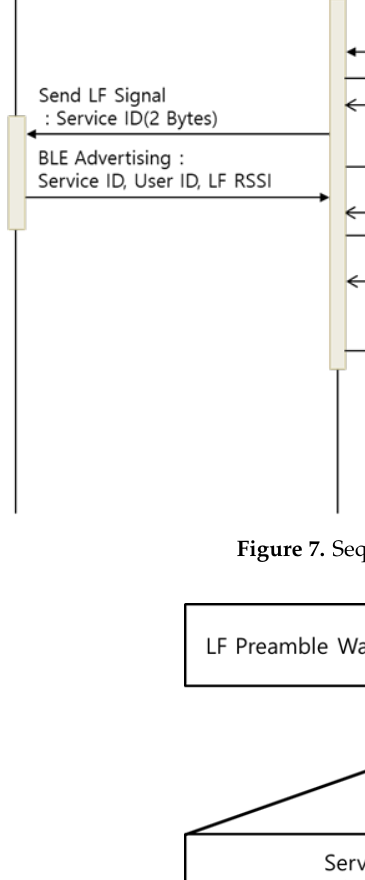
Figure 8. Low frequency (LF) Signal Packet Format.